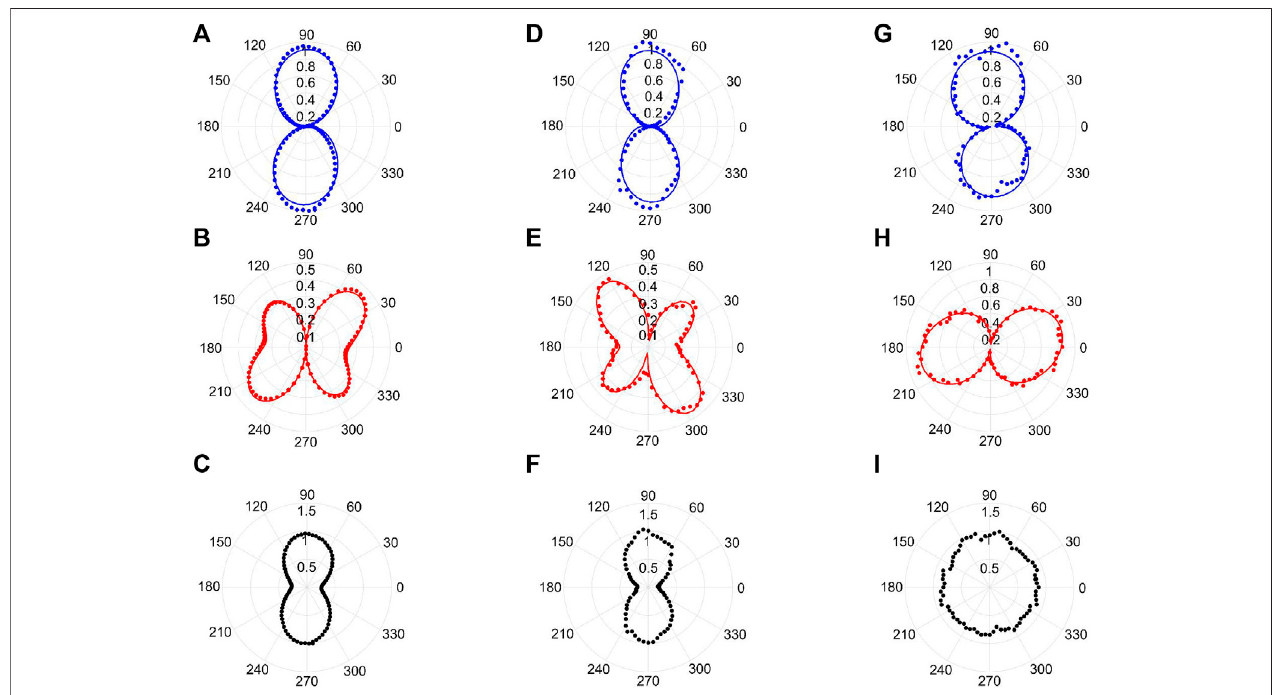
FIGURE 4 | Azimuthal dependence of THz generation from LiNbO 3 . The polar graph of THz peak-to-peak electric fi elds as a function of the rotation angle φ for different emitters. The dots are the experimental data, and the lines are the fi ttings. The left (A – C) , the middle (D – F) , and the right (G – I) columns are the azimuthal dependenceoftheTHzelectric fi eldgeneratedfrom0.5-mmthickLiNbO 3 ,theLiNbO 3 metasurfaceexcitedwiththeresonancewavelengthof1,375 nm,andtheLiNbO 3 metasurface excitedwiththeresonancewavelength of1,395 nm,respectively. Thetop (A,D,G) ,themiddle (B,E,H) ,and thebottom (C,F,I) rowsaretheazimuthal dependence of the THz electric fi eld with polarization along the z -axis, y -axis, and in total, respectively.